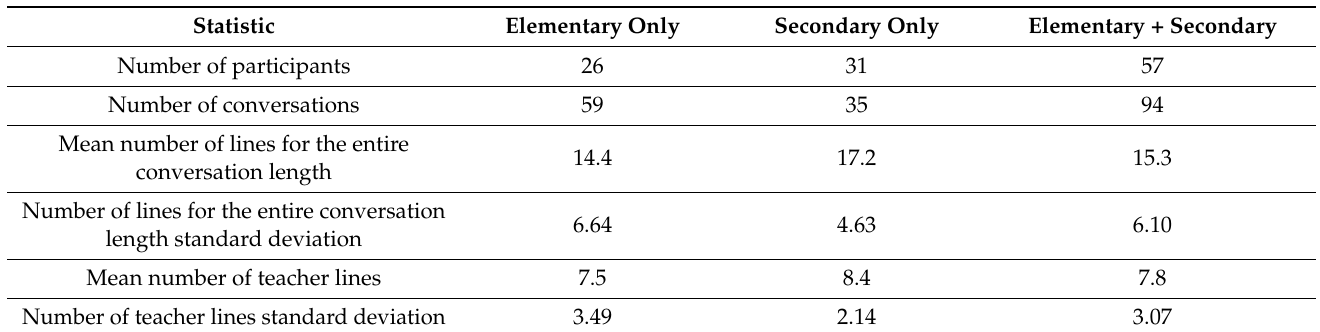
Table 4. Descriptive statistics about ELK